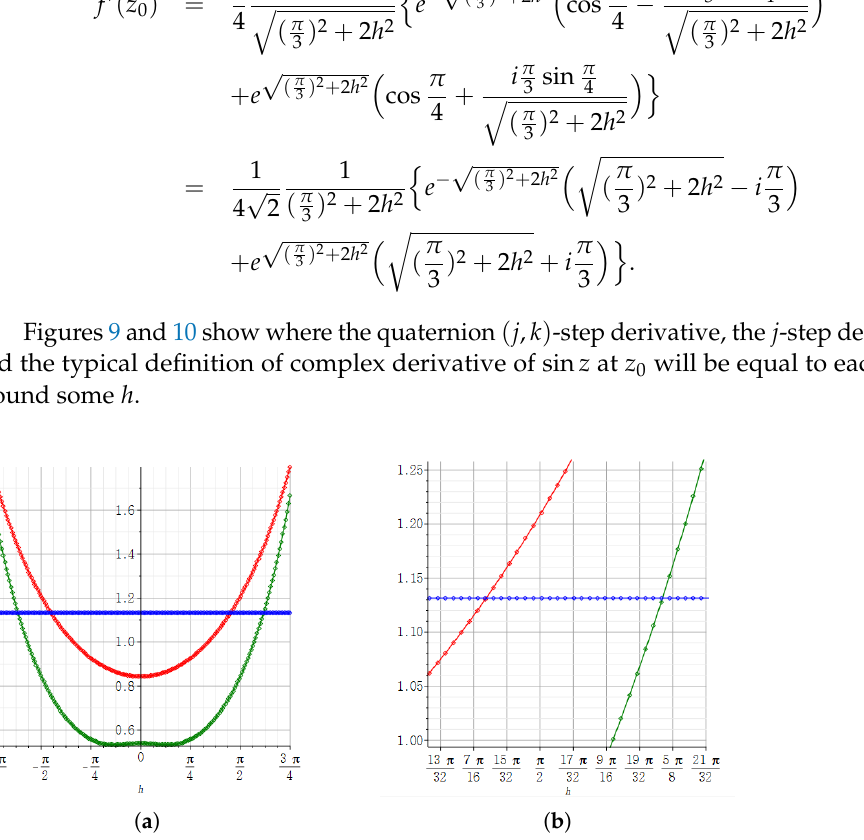
Figure 9. ( a ) shows the result of the real part of the step derivatives of sin z at z 0 according to the size of h by using the Maple plot. ( b ) In the graph of ( a ), the result of zooming in about h near the midpoints of 5 π and 11 π . In ( a , b ), the green graph represents the real part of the ( j , k ) -step derivative, 8 16 the red graph represents the real part of the j -step derivative of cos z at z 0 according to the size of h , and the blue constant graph represents the real part of the derivative of sin z at z 0 by the definition of the derivative for a complex